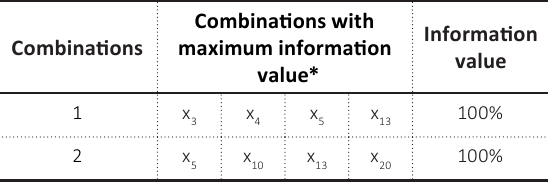
Table 3. Combinations of circular economy indicators, which absolutely separate the clusters of the EU